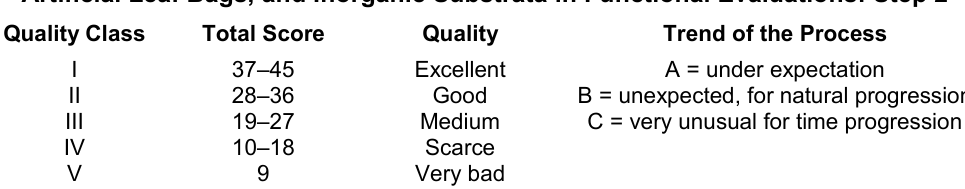
Method for Translating the Macrobenthos Quantity Data of the Natural Leaf Packs, Artificial Leaf Bags, and Inorganic Substrata in Functional Evaluations: Step 2